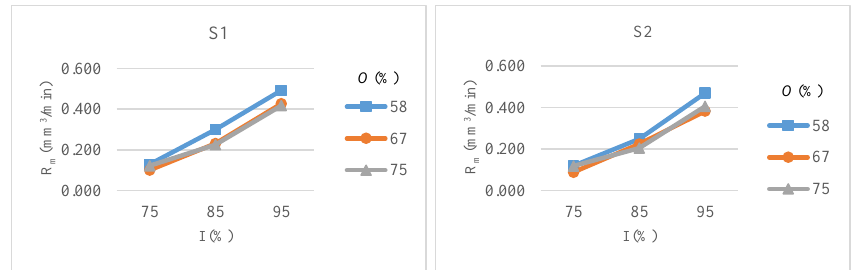
Figure 12. Material removal rate ( R m ) as a function of intensity ( I ) and overlap ( O ) for scanning pattern S1 and S2.